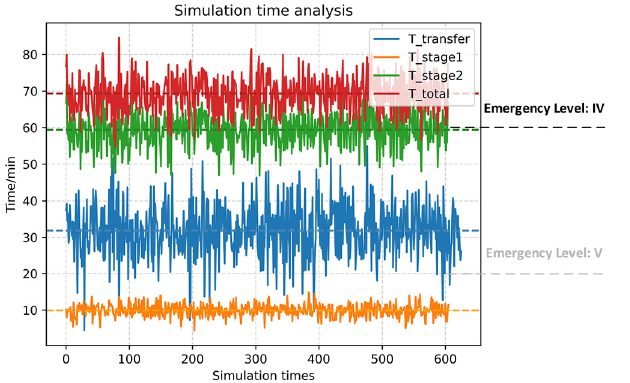
Figure 9. Simulation time